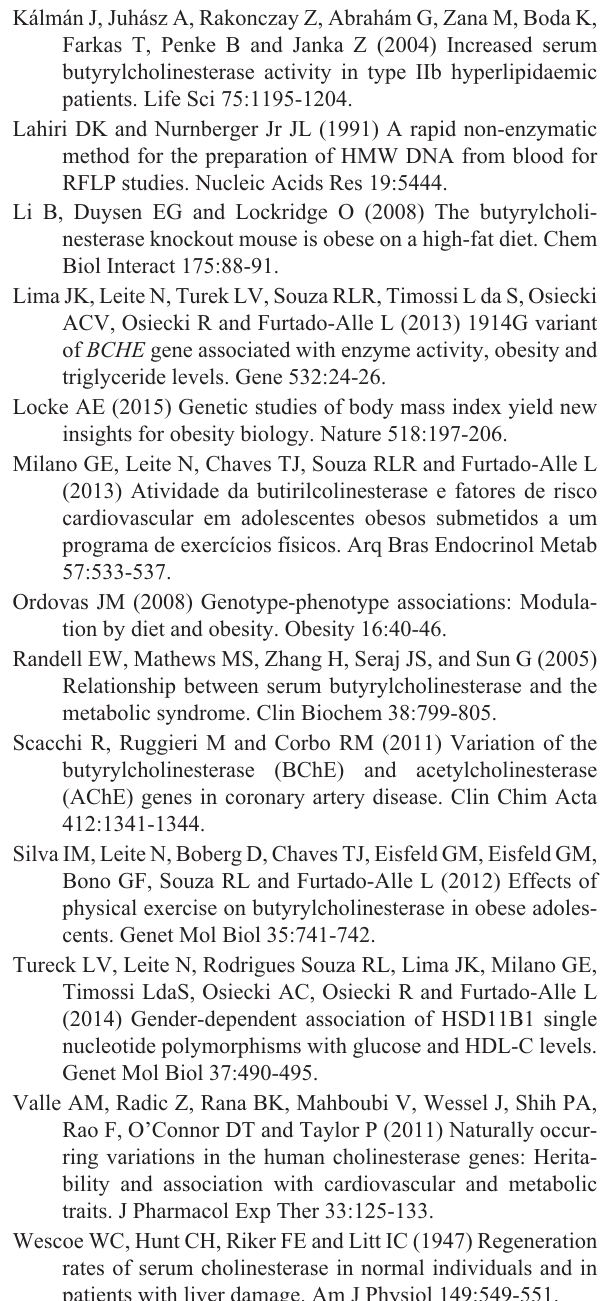
Table S1 – Anthropometric and biochemical variables (mean (cid:3) standard error) in obese and non-obese women stratified by usual homozygous and less frequent alleles carriers for -116G > A, 1615GA and 1914A > G SNPs. Table S2 - Anthropometric and biochemical variables (mean (cid:3) standard error) in obese and non-obese women stratified by usual homozygous and less frequent alleles carriers for 1615GA and 1914A > G